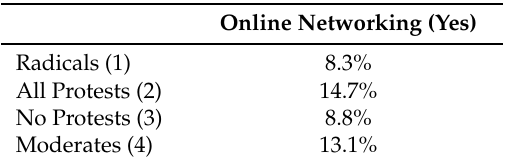
Table 5. Online networking by protest attitude